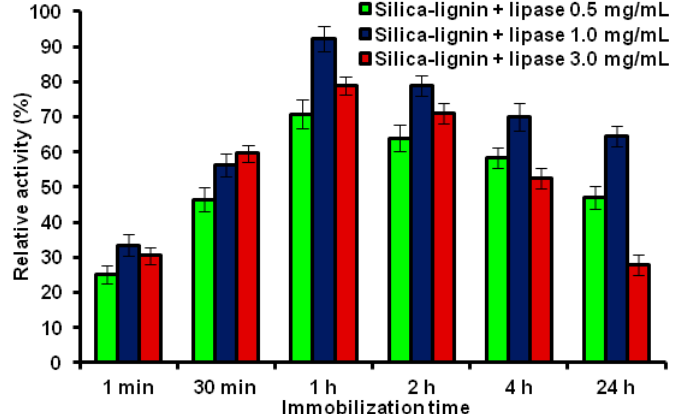
Figure 7. Retention of the catalytic activity of the immobilized enzymes depending on the immobilization time and the enzyme solution